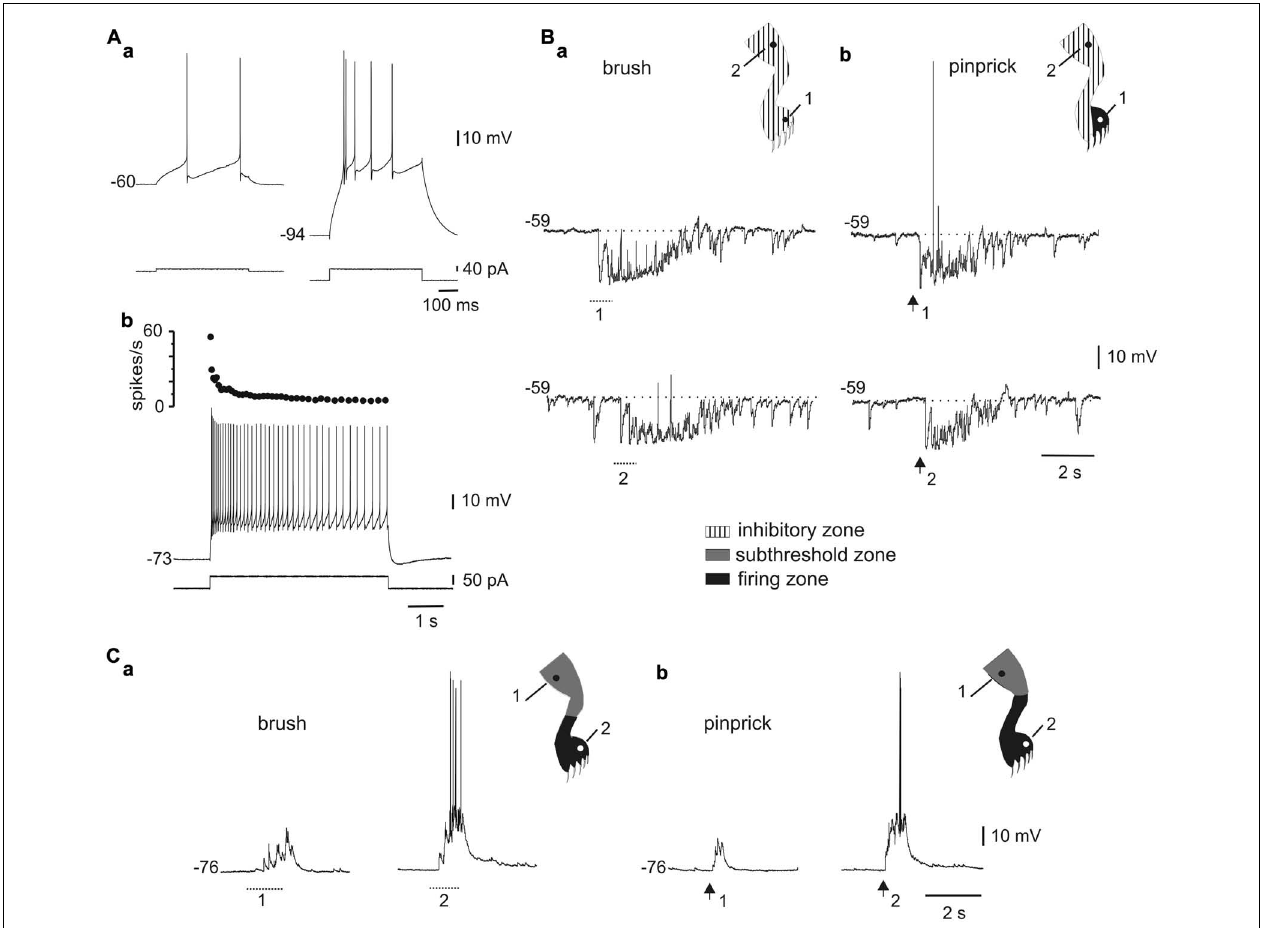
and pinprick (b) applied in two different zones of the ipsilateral hindleg (1 and 2, dots in the cartoons). (C) Responses of a different bursting cell to brush (a) and pinprick (b) .The corresponding receptive fields are shown in the insets. In this and subsequent figures, dotted lines and arrows underneath the traces indicate the time of application of the brush and pinprick stimuli, respectively. ( Aa–Ab) and (Ca–Cb) from the same